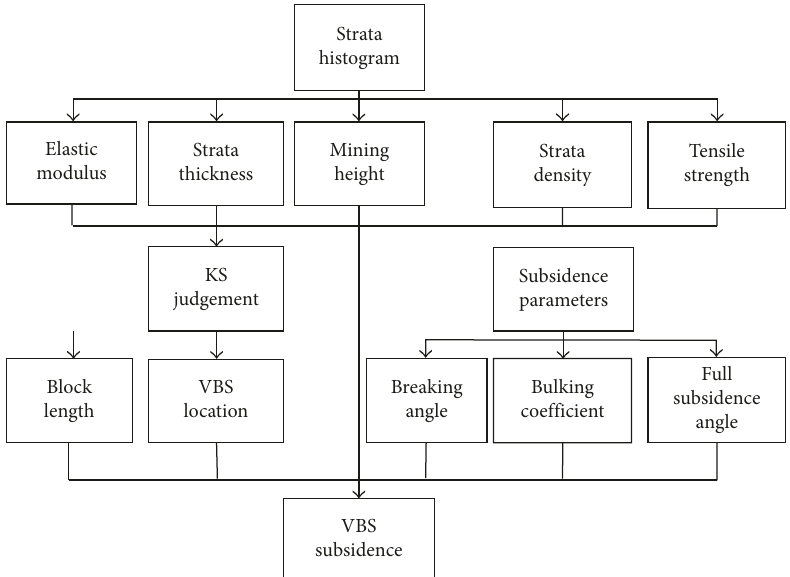
Figure 12: Subsidence calculation steps of the voussoir beam structure.